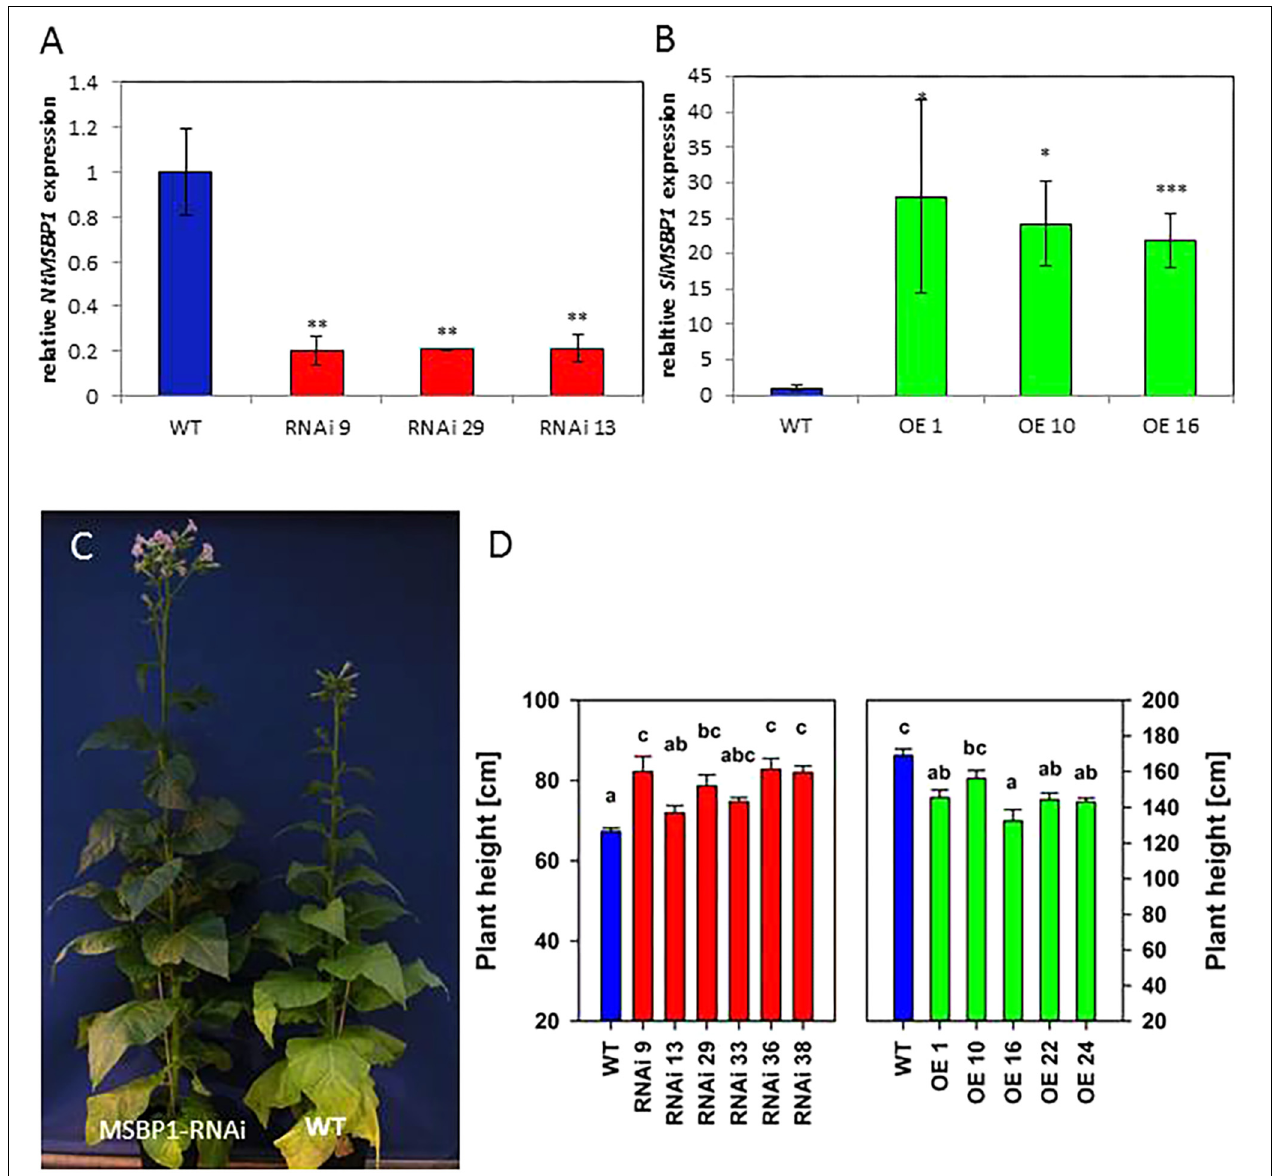
FIGURE 1 | Silencing of NtMSBP1 and overexpression of MSBP1 in transgenic tobacco plants. (A) RNA accumulation analysis in source leaves of NtMSBP1 -RNAi lines and wild type plants. NtMSBP1 relative transcript levels were quantified by qPCR using tobacco genes encoding the translation factor EF1- α and ubiquitin for calibration. The relative expression values of RNAi-plants were normalized to the value obtained in WT plants ( = 1) with ∗∗ P < 0.01. (B) SlMSBP1 expression in MSBP1 overexpressing lines and WT plants. In case of MSBP1 -overexpressing plants SlMSBP1 -specific primers were used. Mean values and SEM are shown for 3–5 biological replicates (with ∗ p < 0.05, ∗∗∗ p < 0.001). (C) Tobacco NtMBSP1 -RNAi line #9 (left) and wild type plant (right). (D) Heights of NtMBSP1 -RNAi lines (left), MSBP1 overexpressing lines (right) and wild type plants. Mean values and standard deviations are shown for 5–8 replicates (transgenic lines) or 16–28 replicates (wild type). Significant differences between values of the RNAi lines and wild type plants are indicated by different letters according to one way ANOVA with post hoc Tukey test and the SE is given. Differences in total plant height in the two experiments are due to differences in pot size and growth